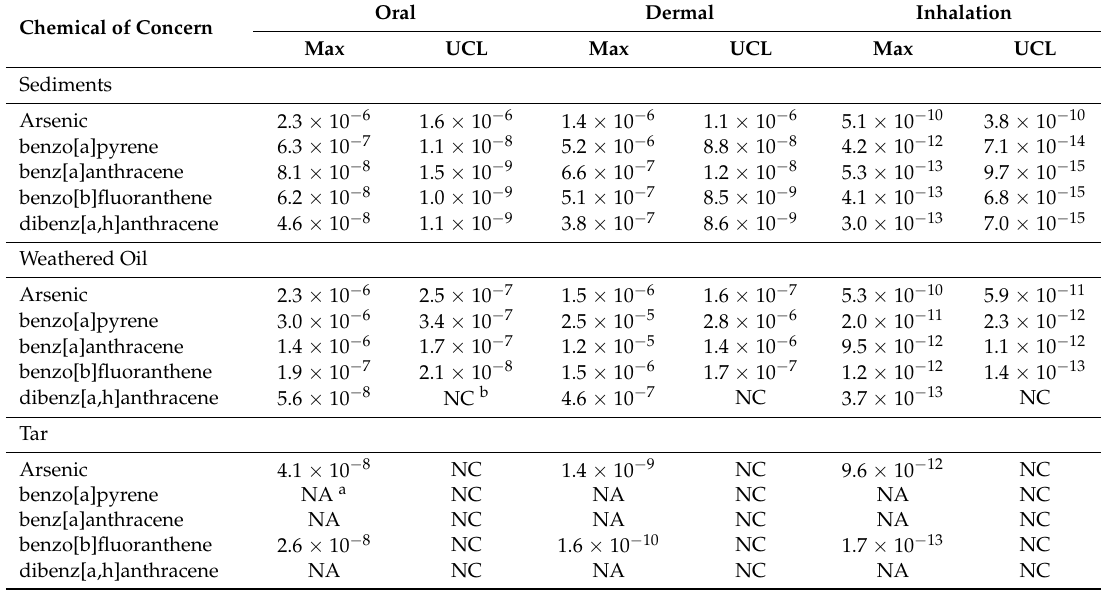
Table 7. Cancer risk from sediment, weathered oil, and tar using maximum and UCL